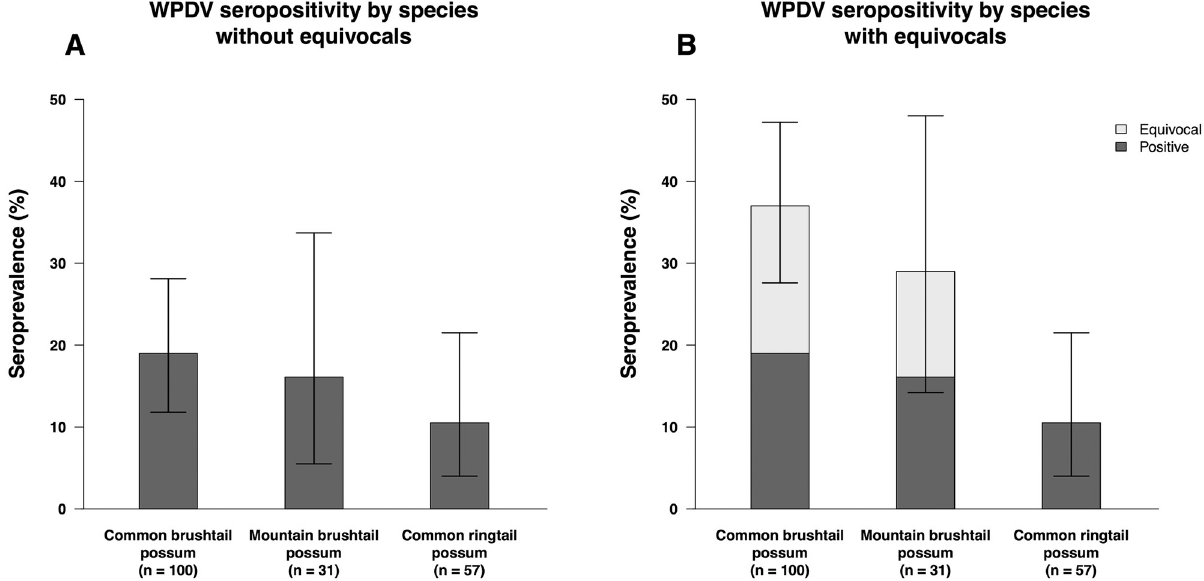
Fig 1. The percentage of possums seropositive for antibodies to WPDV in Australia, stratified by species. Samples were considered positive if their corrected OD 450 > 0.41 and equivocal if 0.28 < corrected OD 450 � 0.41. Sera (n = 188) were obtained from wild-caught, apparently healthy possums (archival samples) or injured/sick possums presented to wildlife centres in various geographical regions in Australia. Bar plots showing the percentage of seropositive samples in A and including both seropositive and equivocal samples in B, with 95% confidence intervals.